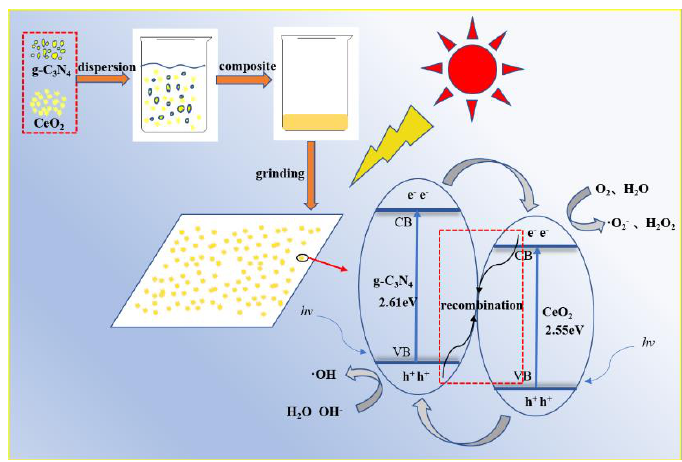
Figure 2. Principle of purifying exhaust gas with a g-C 3 N 4 /CeO 2 composite material.